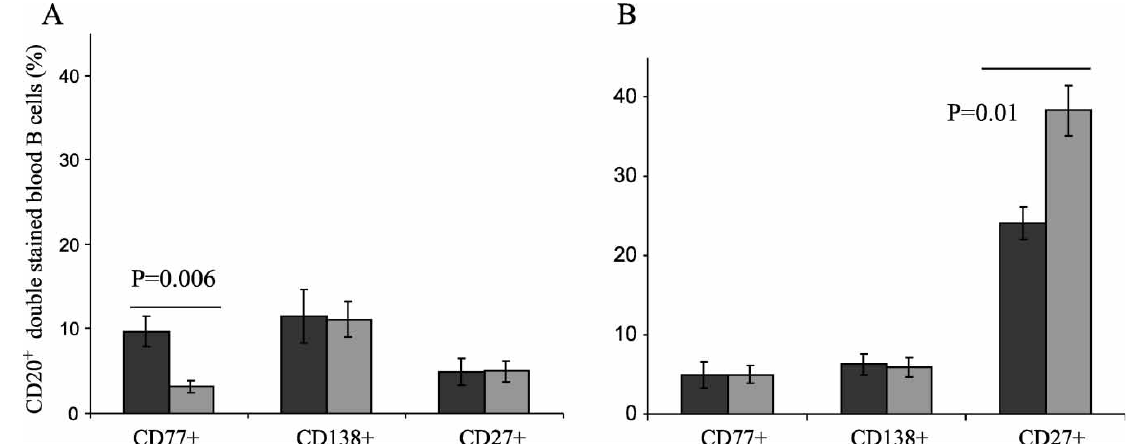
FIGURE 2 Differential expression of CD77, CD138 and CD27 markers on circulating CD20 þ B cells. (A) African blood donors; (B) European blood donors; Black bars, HIV-infected individuals; Gray bars, HIV-uninfected